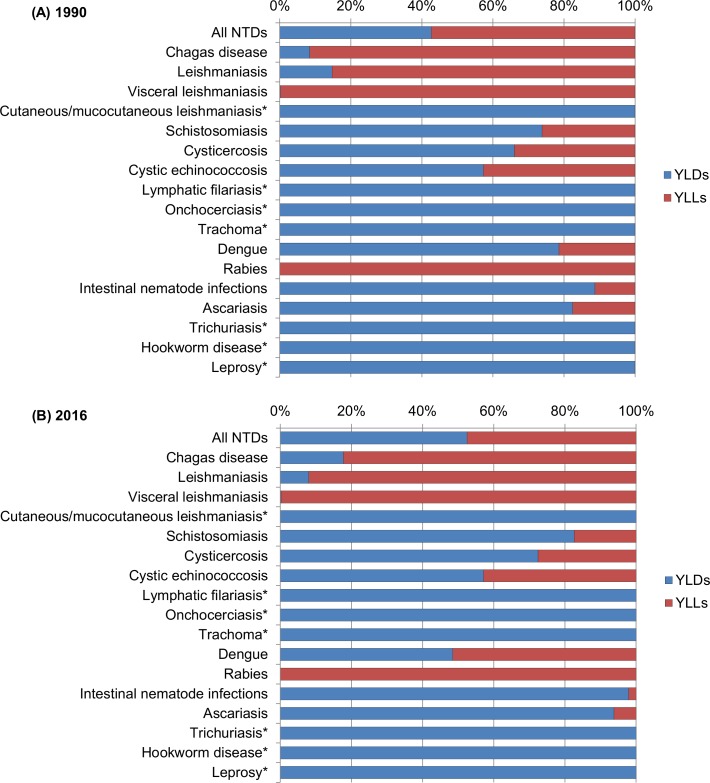
Contribution of YLDs and YLLs to total DALYs for each Neglected Tropical Disease in Brazil for (A) 1990 and (B) 2016. *For these causes, YLL is assumed to be zero. YLDs were equivalent to DALYs. YLDs = years lived with disability; YLLs = years of life lost; DALYs = disability-adjusted life-years; NTDs = neglected tropical diseases.